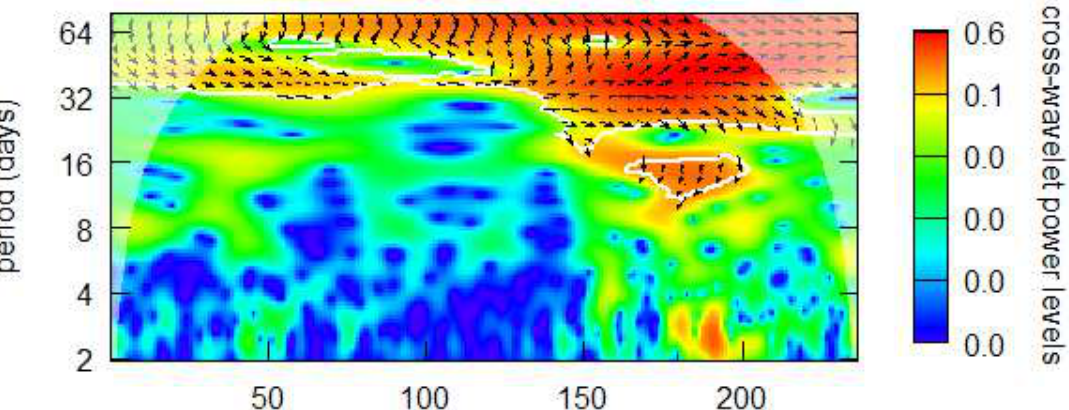
Figure 4. Shanghai Stock Exchange and NASDAQ